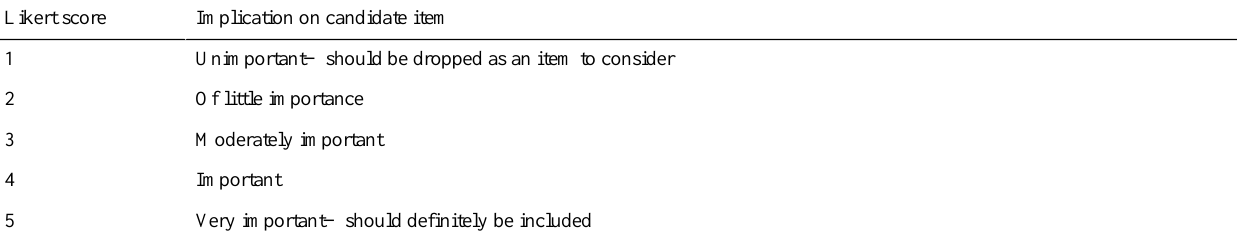
Table 1. Implication of Likert score on candidate